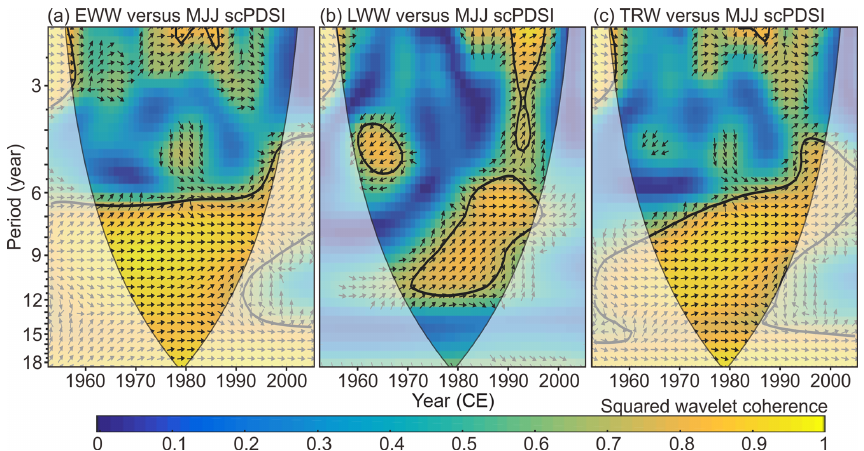
Figure 5. Squared wavelet coherence and phase relationship between the NELR-based tree-ring-width STD chronologies and MJJ scPDSI. Panels (a) – (c) represent the results for EWW, LWW, and TRW, respectively. The color bar indicates the squared wavelet coherence. The arrows indicate the phase relationship with in-phase (anti-phase) pointing right (left), and MJJ scPDSI leading (lagging) tree-ring width with 90 ◦ pointing straight up (down). The thick contour indicates the 5% significance level against red noise. The cone of influence (COI) where edge effects might distort the picture is marked in a lighter